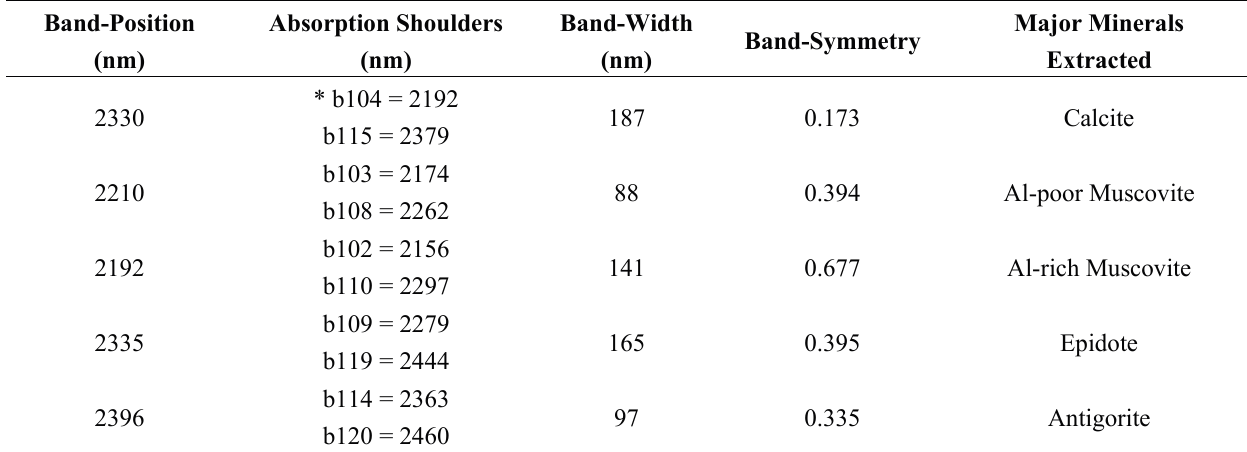
Table 3. Detailed absorption feature